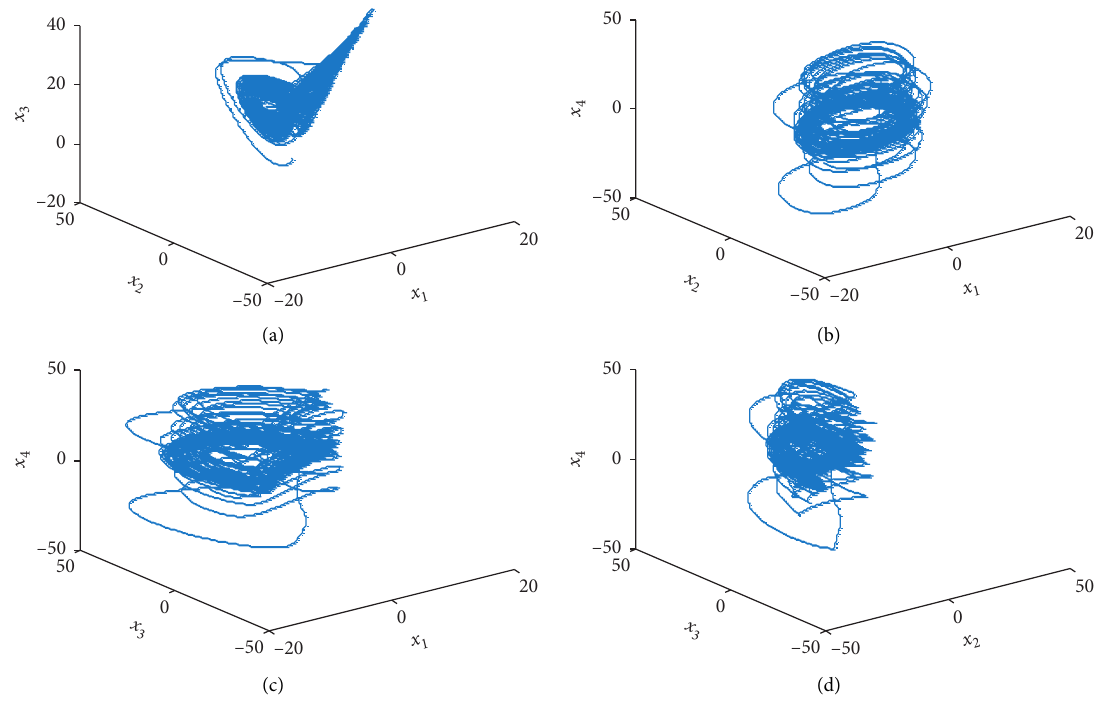
Figure 5: Typical dynamical behaviors of the hyperchaotic Lorenz system: (a) projection in ( x space; (c) projection in ( x